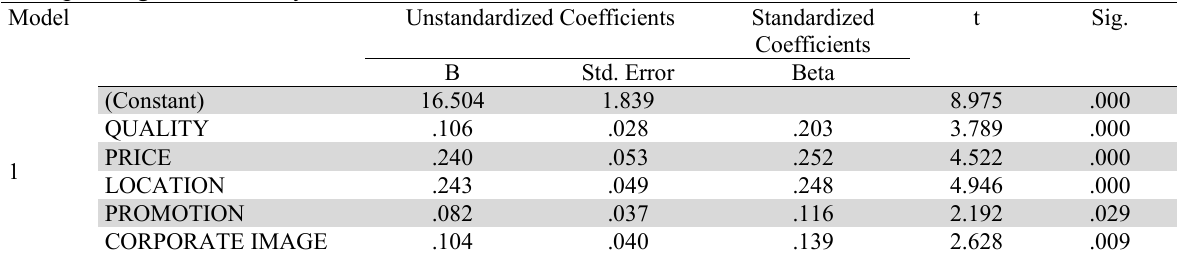
Multiple Regression Analysis Test